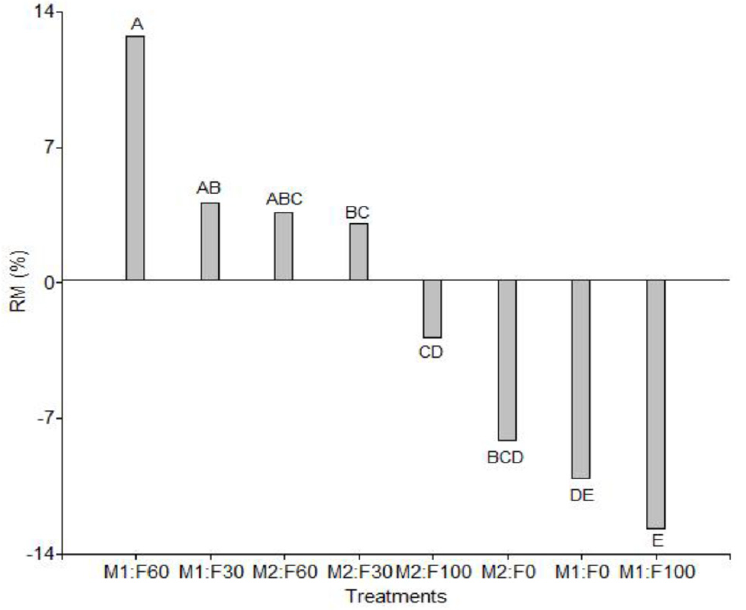
Figure 1. Mycorrhizal response of stem neck diameter for AMF and level chemical fertilizer. Different letters indicate significant differences according to the Kruskal–Wallis test.